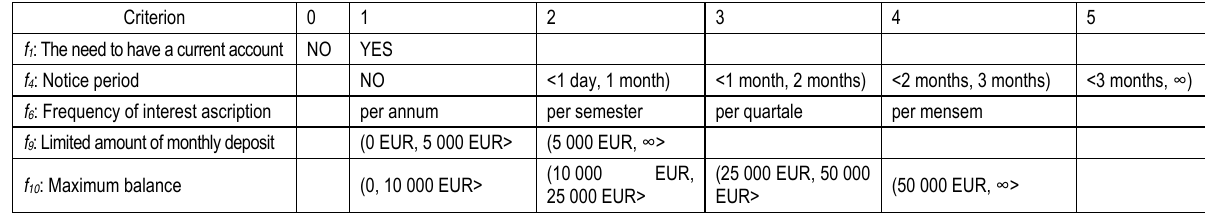
Table 6 Quantification of qualitative criteria of savings